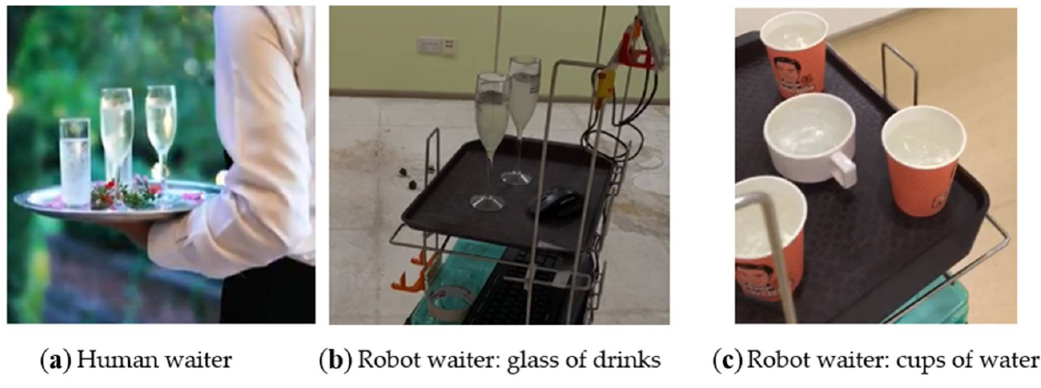
Figure 1. Serving liquid.